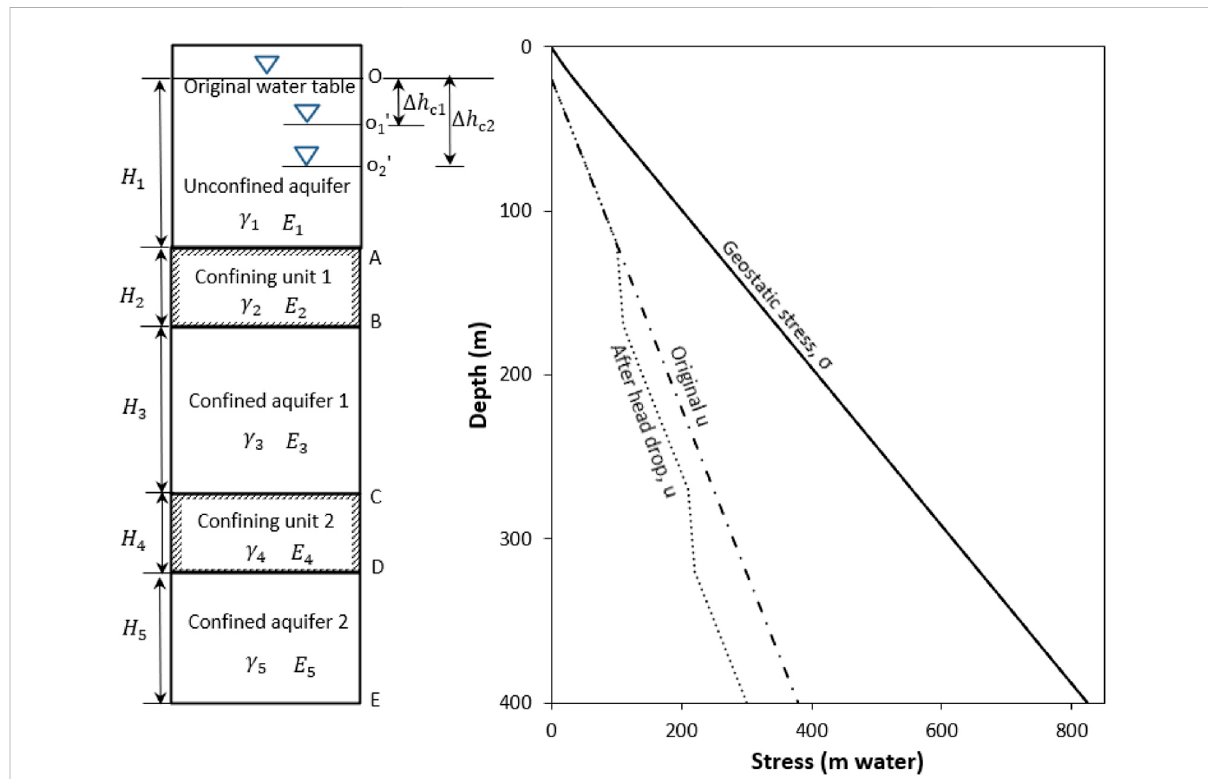
FIGURE 3 Stress diagrams for a water head drop of 40 m in con fi ned aquifer 1, and 80 m in con fi ned aquifer 2 ( γ g (cid:1) 2 . 6 × 10 4 N / m 3 ; γ w (cid:1) 9 . 8 × 10 3 N / m 3 ; n (cid:1) 0 . 35; n w (cid:1) 0 . 08).